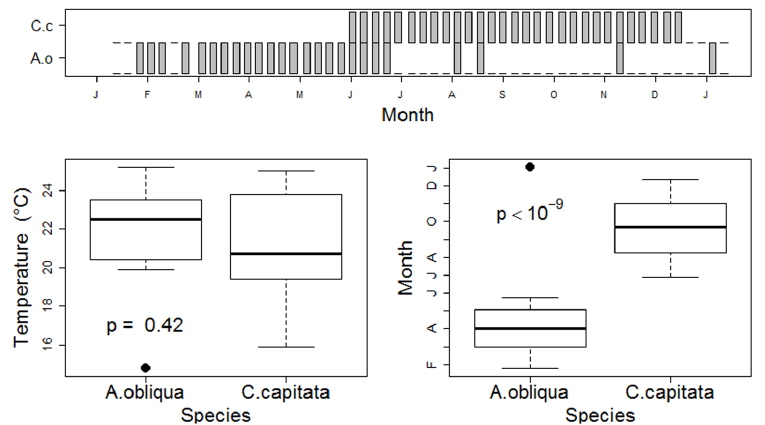
Fig 1. Co-occurrence pattern based on presence-absence data of a significantly segregated species pair, A . obliqua ☓ C . capitata . The upper panel illustrates the co-occurrence patterns in temporal samples of A . obliqua (unfilled bars) and C . capitata (grey bars) collected in a loquat orchard in 2002. Box plots illustrate average air temperature (°C) and Julian collection date (plotted on a monthly scale) for samples that contained only A . obliqua or only C . capitata (temporal checkerboards). This species pair is segregated on the basis of seasonality, but not on the basis of temperature.